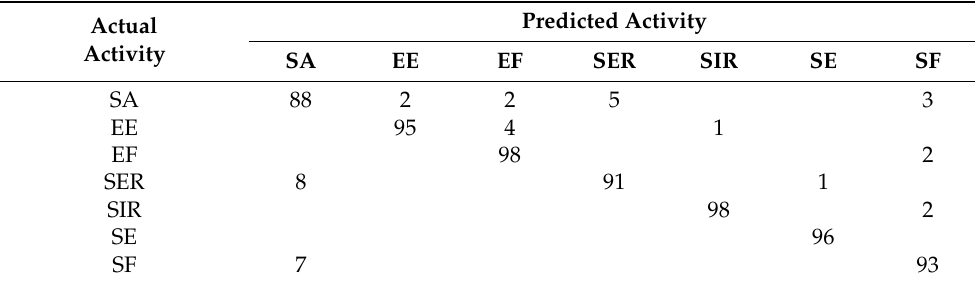
Table 4. Confusion matrix for KNN classifier (in %). Cells with value 0 are left blank.